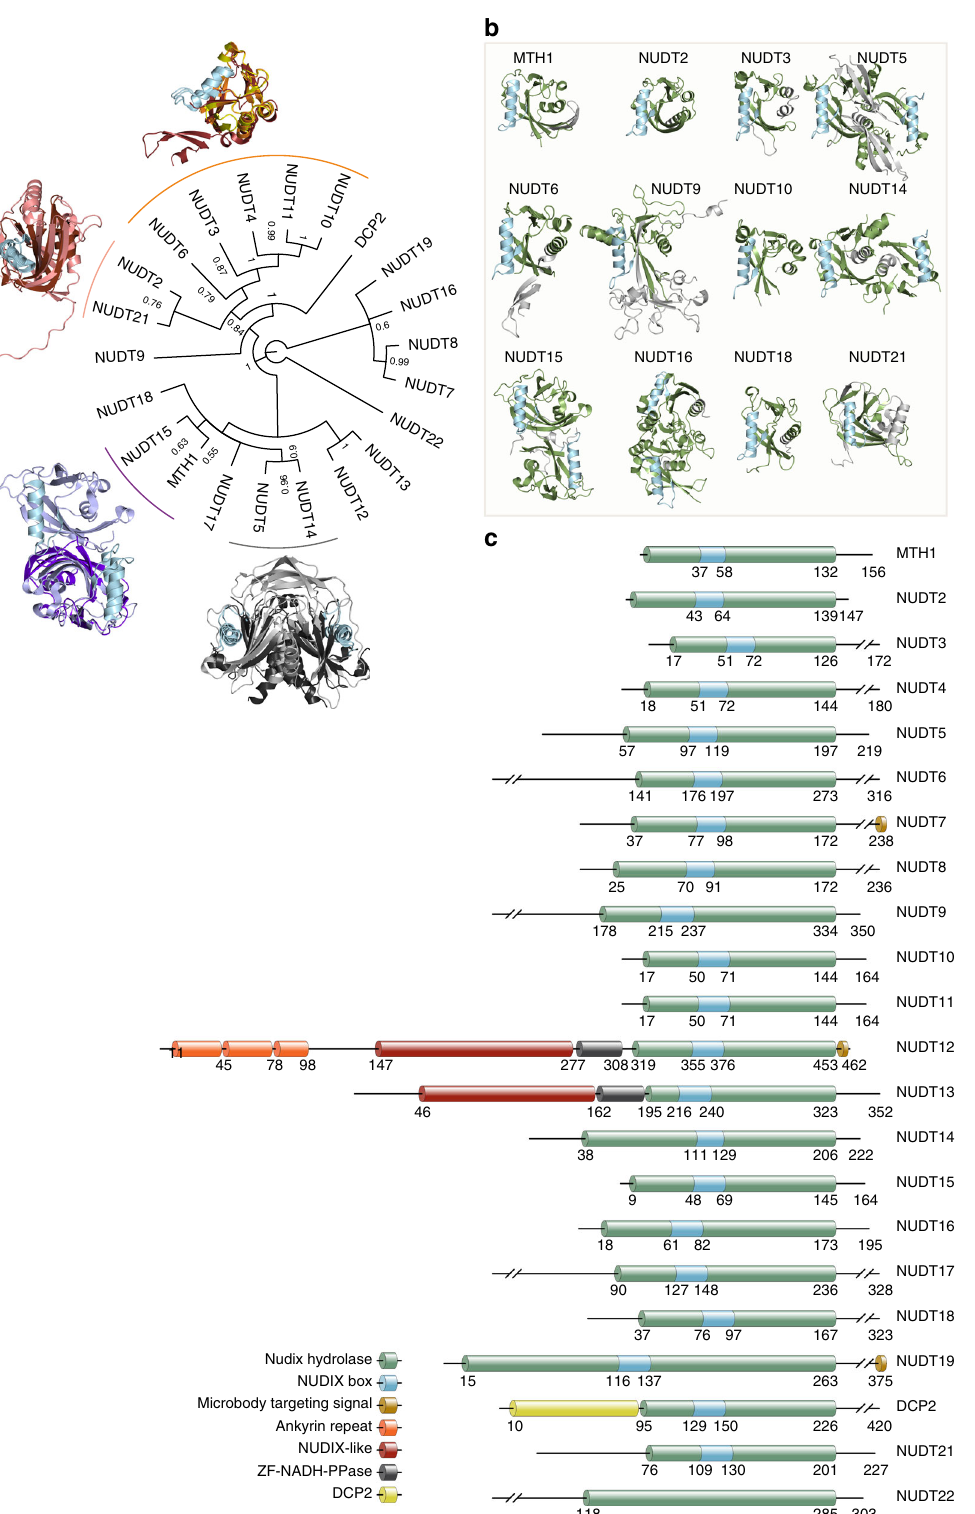
Fig. 1 Sequence and structural analysis of human NUDIX hydrolases. a Consensus phylogenetic tree of full length Human NUDIX proteins with posterior probabilities of each branch provided. Distinct groups with known structures are overlaid for comparison. MTH1 (purple) and NUDT15 (light blue); NUDT5 (gray) and NUDT14 (black); NUDT21 (pink) and NUDT2 (brown); NUDT6 ( fi rebrick red), NUDT3 (yellow), and NUDT10 (orange). b Known structures of human NUDIX proteins modeled in cartoon format with the NUDIX box colored in blue, NUDIX fold domain in green, and remaining structure colored in gray. c Graphical representation of the different domains within the human NUDIX